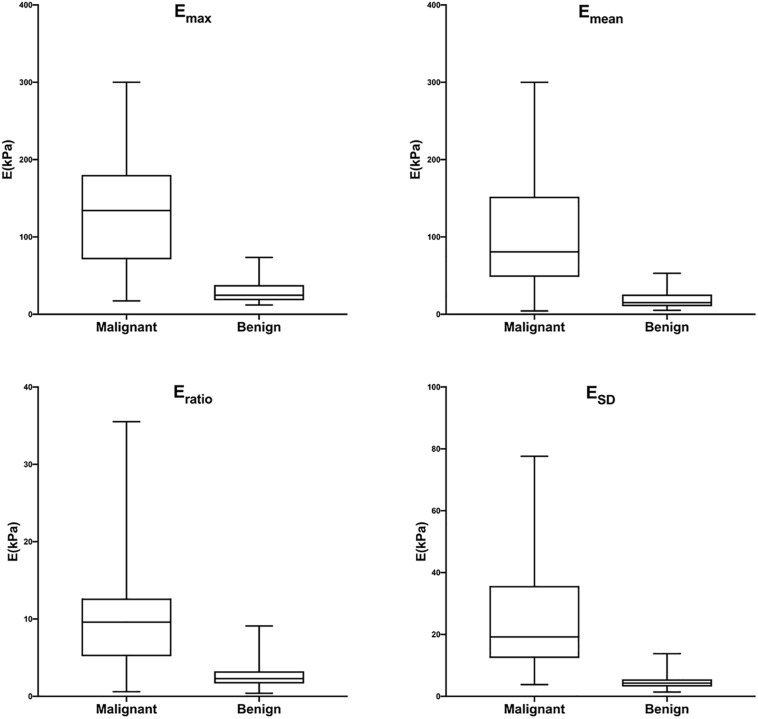
Box-and-whisker plots of Emax, Emean, Eratio, and ESD in malignant and benign lesions in the training cohort. The top and bottom of each box represent the 75th and 25th percentiles, respectively. The horizontal line in each box represents the median; the top and bottom of the whiskers represent the minimum and maximum values, respectively. Emax, Emean, Eratio, and ESD were significantly higher in malignant lesions than in benign lesions (P < 0.001 for all).